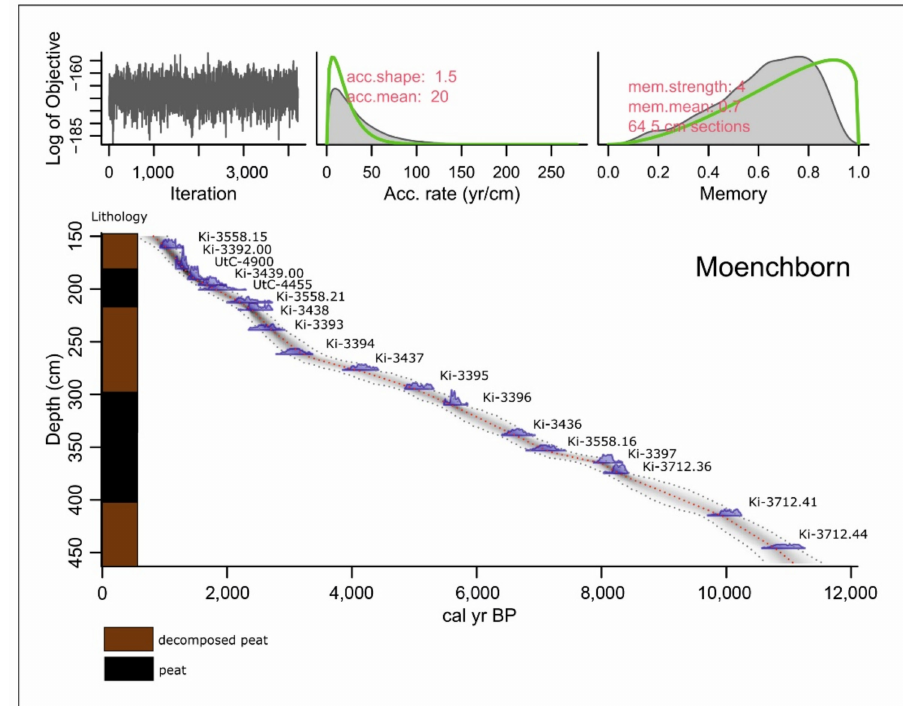
Figure 2. Age-depth model of profile Moenchborn.